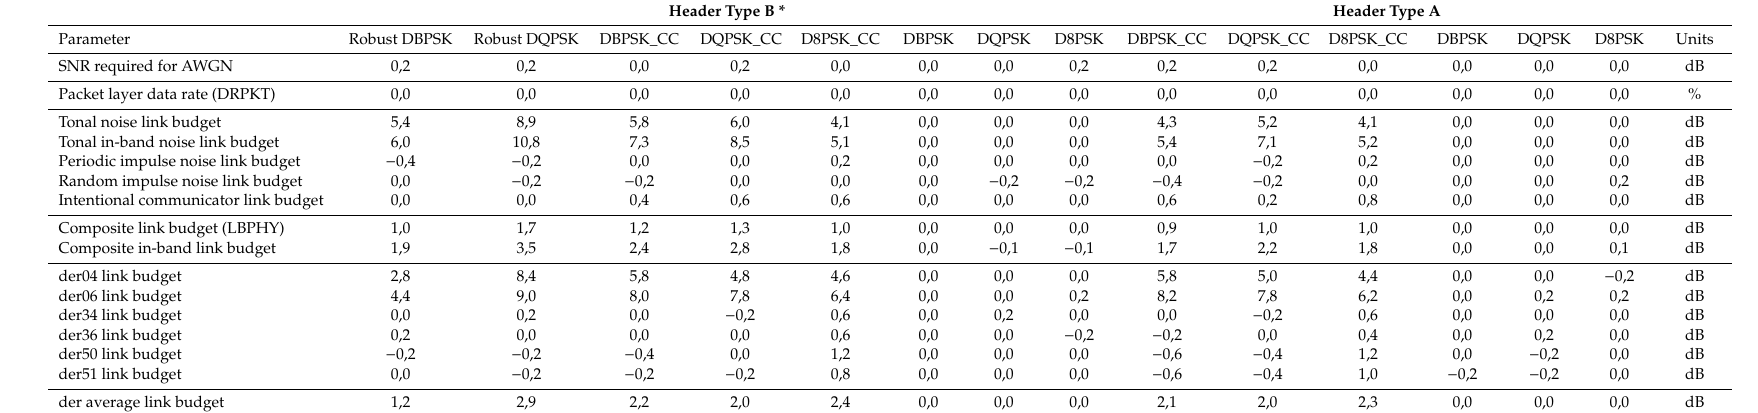
Table 5. Incremental results with the spline equalizer compared to the polynomial equalizer presented in [10] for PRIME 1.3.6 and 1.4. Header Type B * Header Type